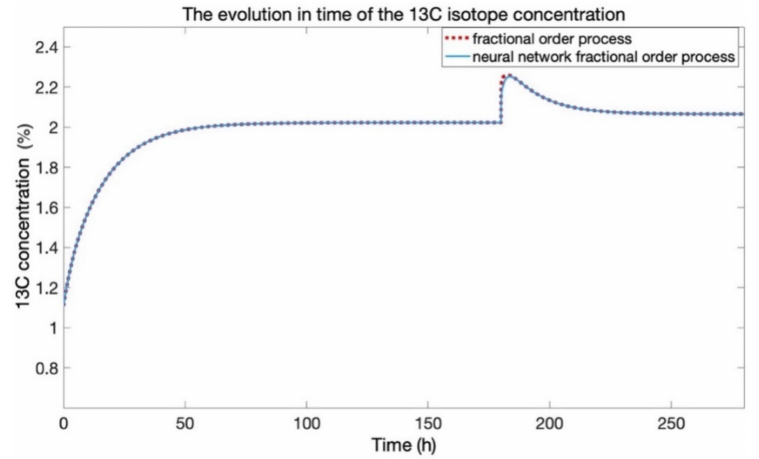
Figure 16. The proof of the proposed adaptive model efficiency in learning the increasing dynamics of the 13 C separation process when the fractional differentiation order varies increasingly from β = 0.91 to β = 0.97 at t = 180 ( h ) .